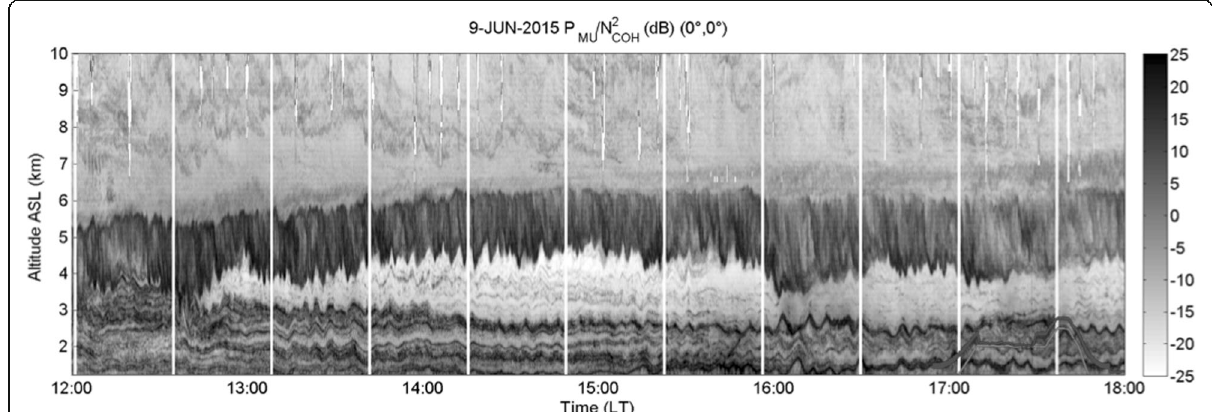
Fig. 6 As in Fig. 1 but from 12:00 to 18:00 LT on June 9, 2015, during the ShUREX 2015 campaign. A strong MCT event with the cloud base around 5 – 6 km altitude (ASL) can be seen. This was the only occasion during all three campaigns, when wave-like structures were observed in the MU radar image (between 12:30 and 18:00 LT at altitudes between 1.4 km and the bottom of the MCT layer). The apparent period is 4 to 8 min. The lines between 17:00 and 18:00 LT denote UAV